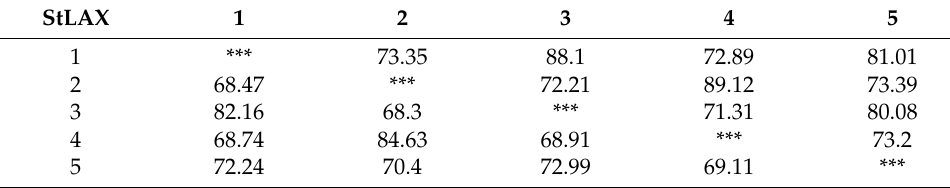
*** represents no data